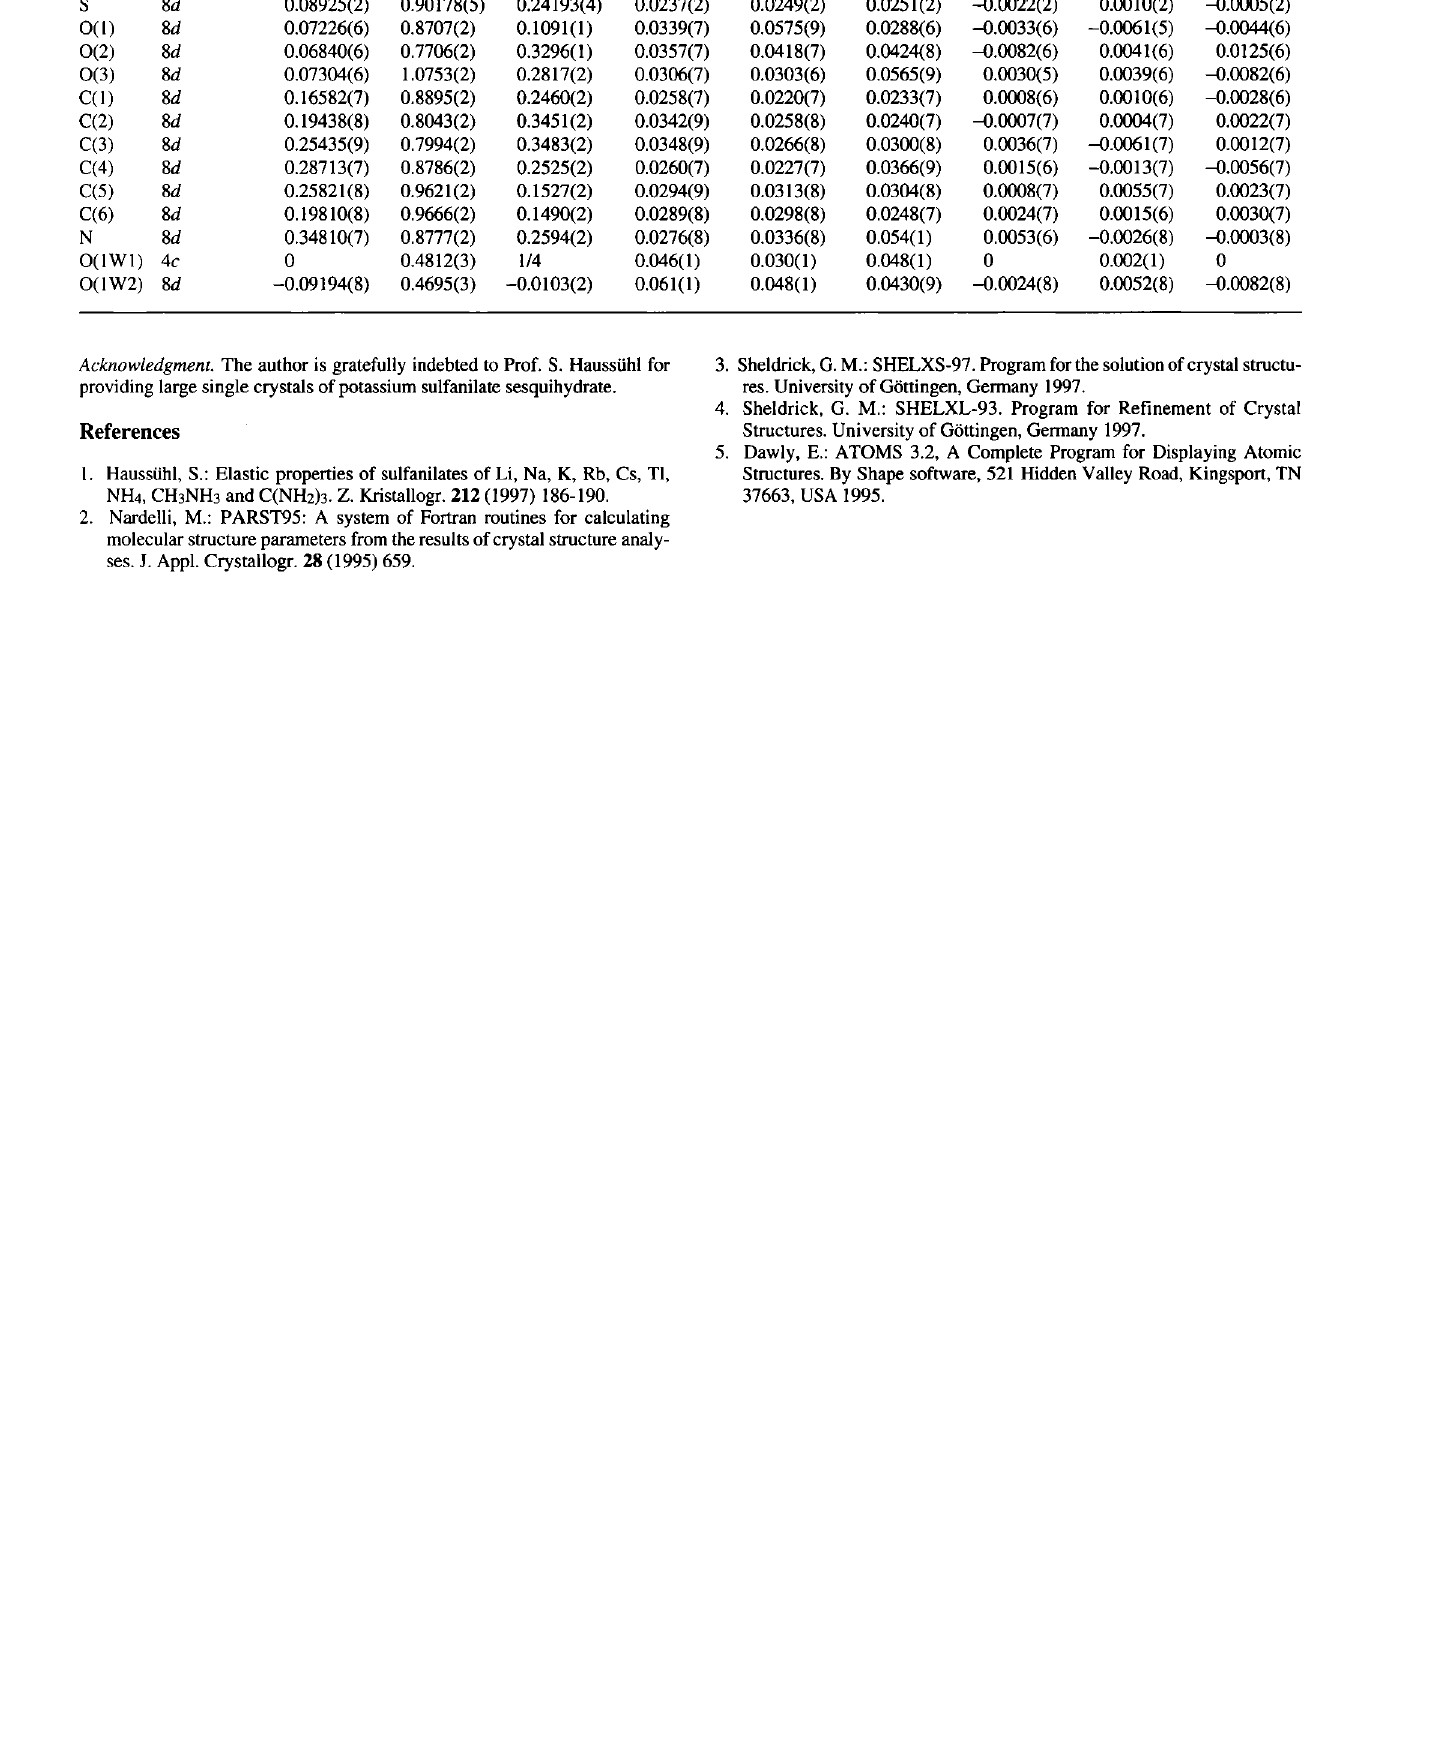
Table 3. Atomic coordinates and displacement parameters (in Ä 2